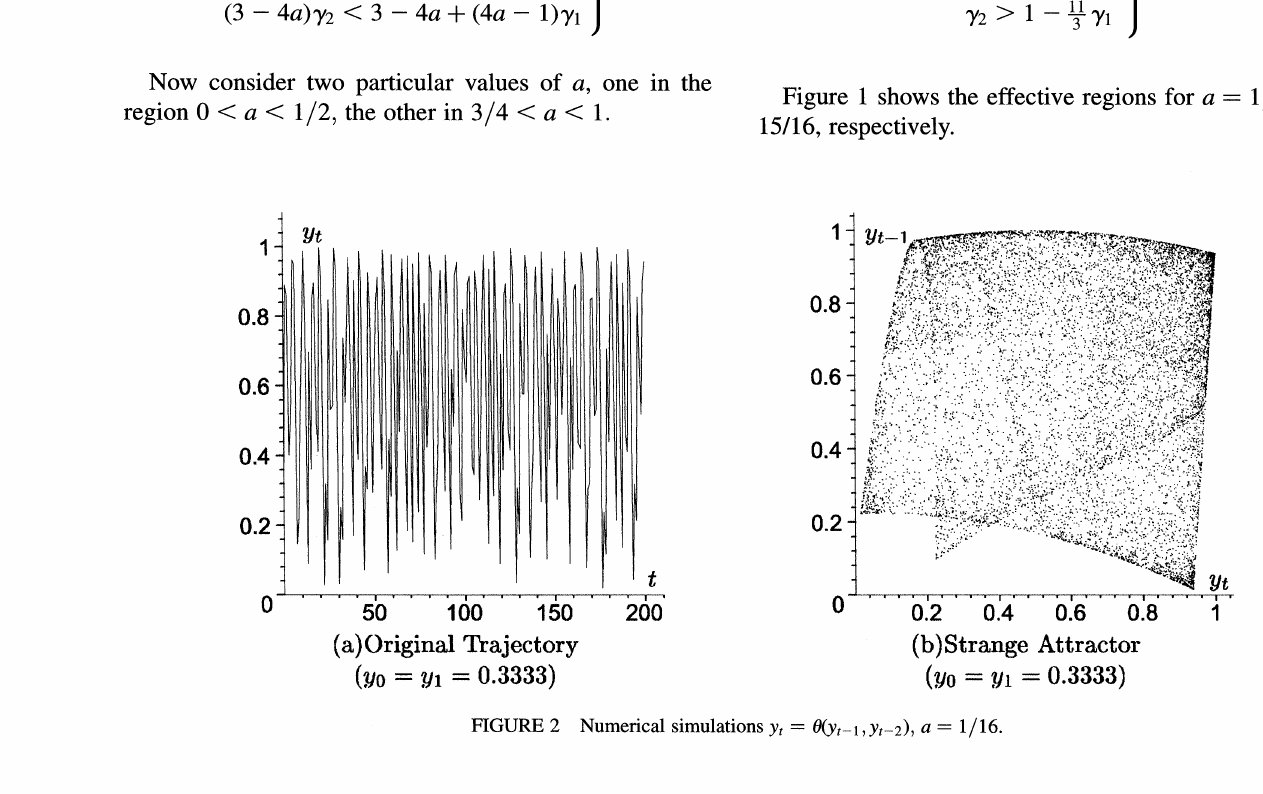
FIGURE Effective Region.